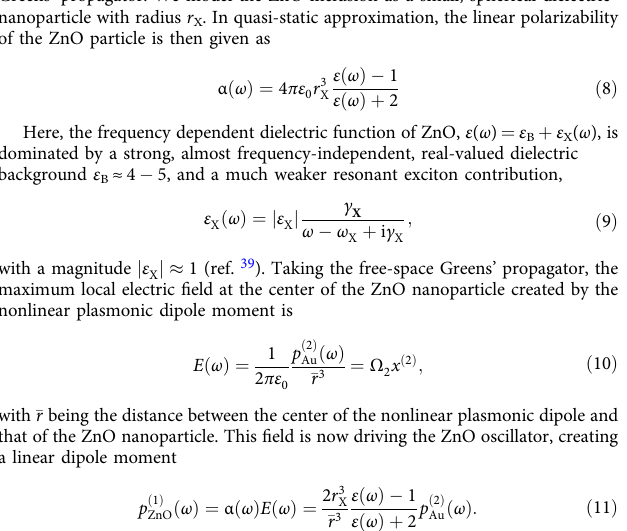
= 2.35 fs − 1 and T = 3 fs. Supplementary Figure 21 shows the response dp 2,dp functions of the dipole mode and the three hot spot modes, and their